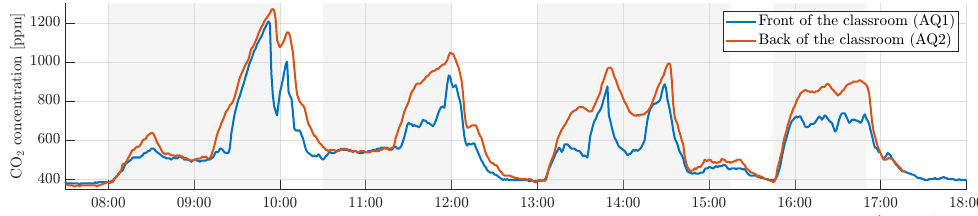
Figure 8. Example of CO 2 measurements at the front and at the back of the classroom. The grey shaded background identifies occupation periods.